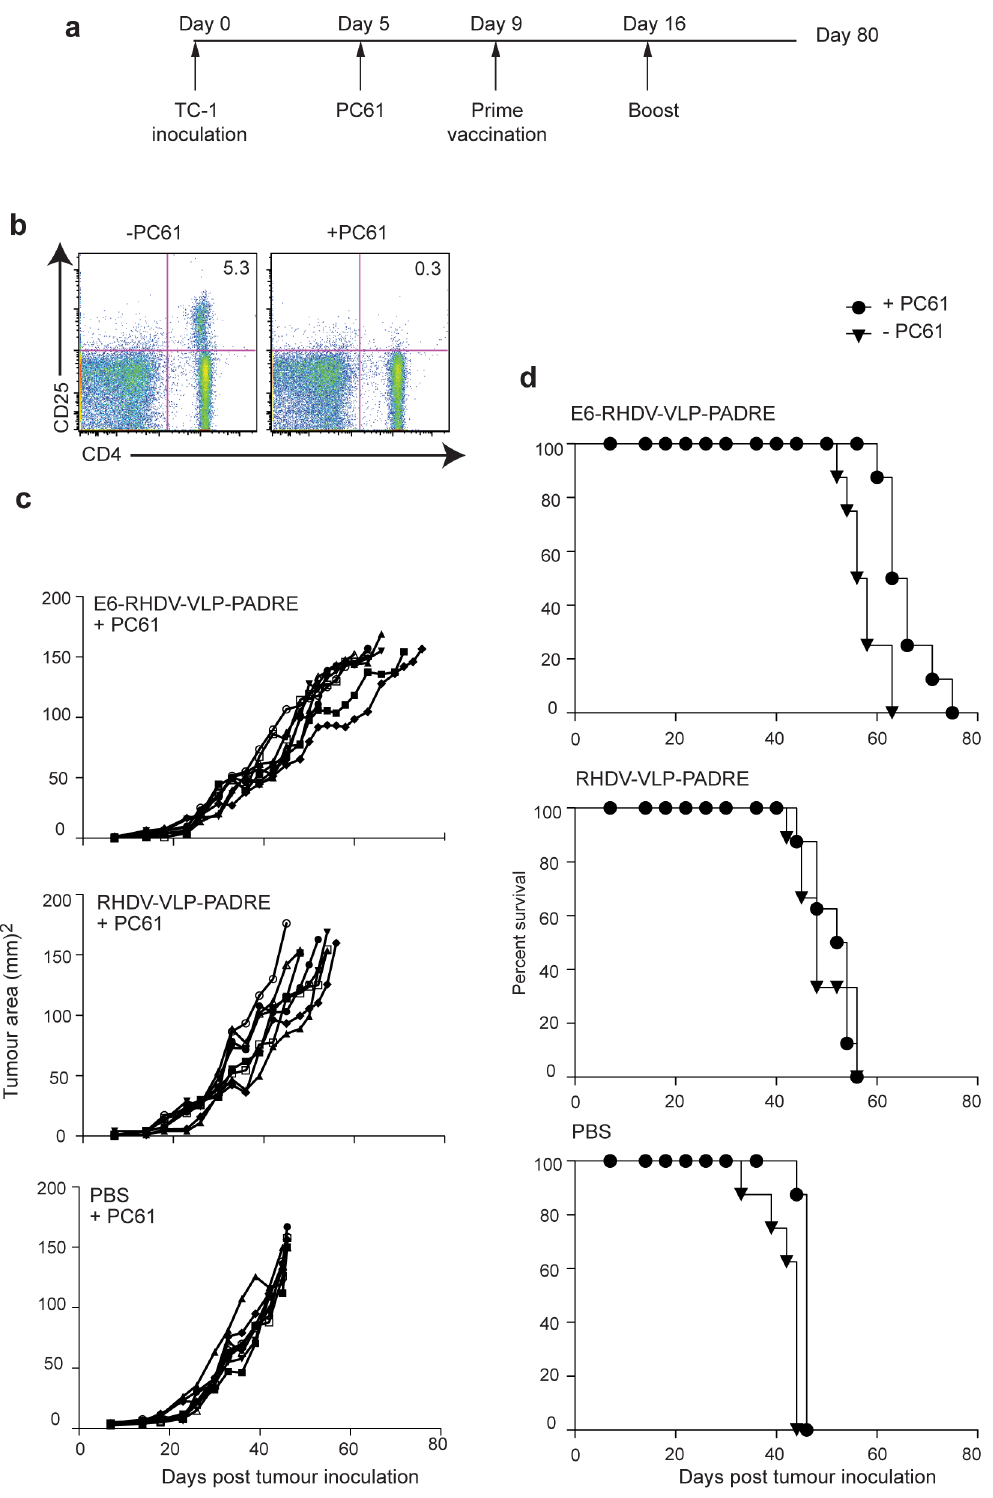
Figure 4. The administration of PC61 further improves the efficacy of E6-RHDV-VLP-PADRE. (a) Schematic diagram depicting the schedule of tumour administration, PC61 injection and the prime and boost vaccination. (b) Flow cytometric analysis for CD4 + and CD25 + T cells four days following CD25 depletion by injection of 170 m g PC61 ip. Inguinal lymph node cells from an untreated mouse (left panel) and a treated mouse (right panel). (c) Tumour area of mice (eight per group) vaccinated with E6-VLP-PADRE, VLP-PADRE or PBS following administration of PC61. (d) Kaplan-Meier analysis of mice vaccinated with E6-VLP-PADRE, VLP-PADRE or PBS, each with or without PC61 treatment.